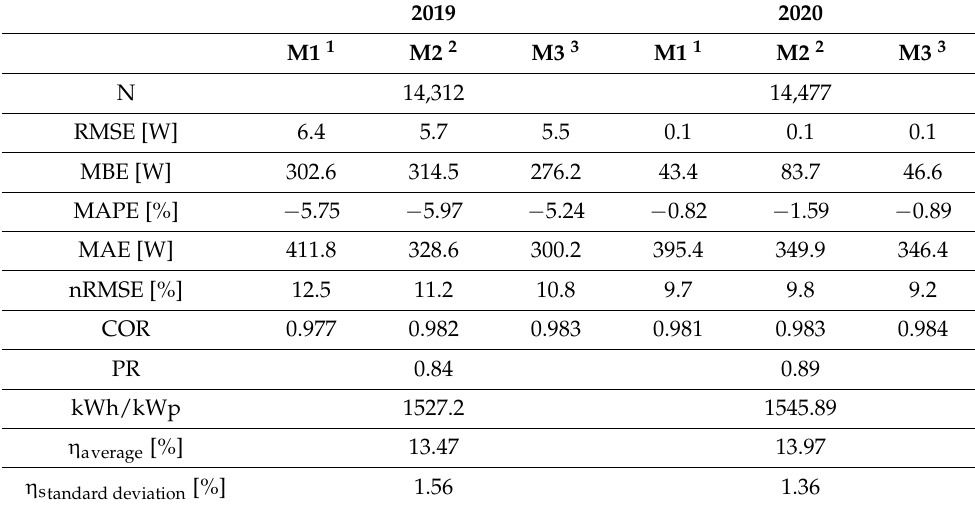
Table 3 compares the performance prediction for 2019 and 2020 for the regression model and FF ANN with 3-year training, and the FF ANN with 5-year training. The ANN